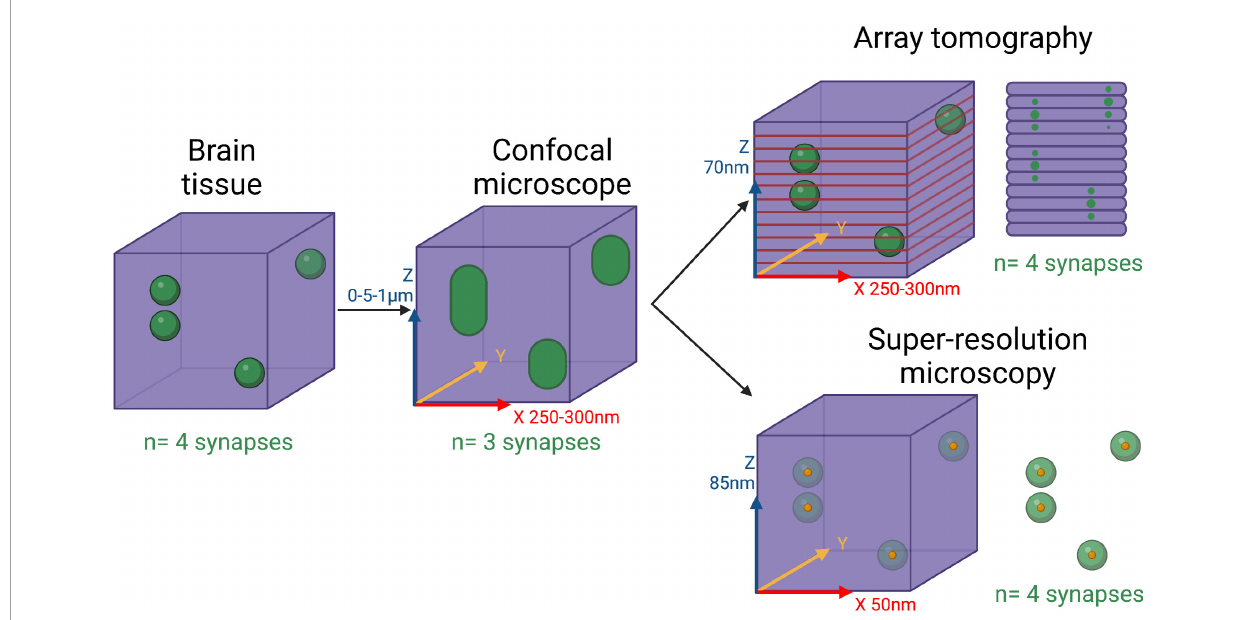
FIGURE1 Limitations of confocal microscopy for 3D synaptic imaging. Diagram showing 4 synapses in a 3-dimensional piece of brain tissue and how different imaging approaches would resolve them. Confocal microscopes have a diffraction-limited resolution in all axis, meaning two synapses in close proximity will be observed as just one large entity. To solve this problem, array tomography resolves all the synapses by cutting the tissue very thin (70 nm) thus setting the axial resolution by the thickness of the sections. 3D super-resolution single molecule light microscopy is able to pinpoint all synapses by carefully identifying the central point of each synapse and highlighting them separately. Resolutions achieved by the different techniques are shown in the axis. Created with BioRender.com.